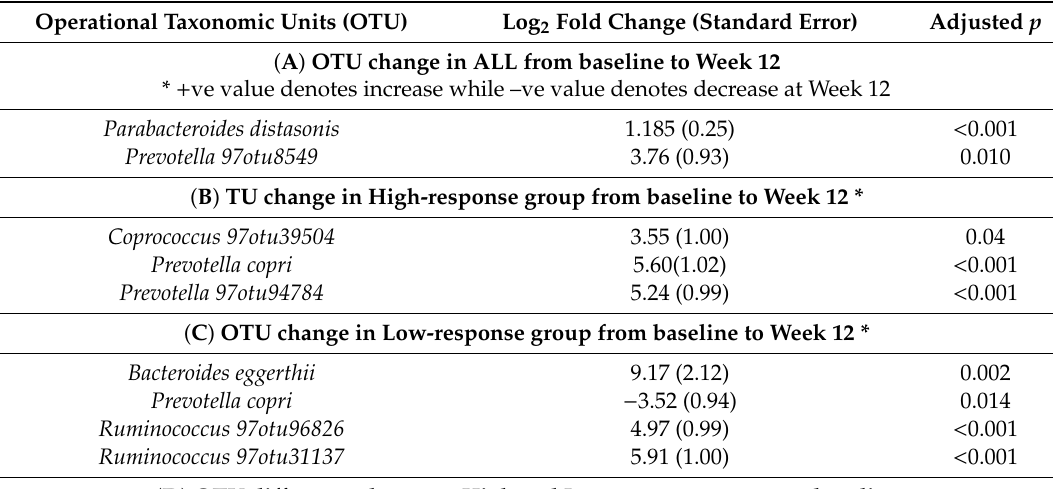
Table 5. Di ff erential microbial abundance related to